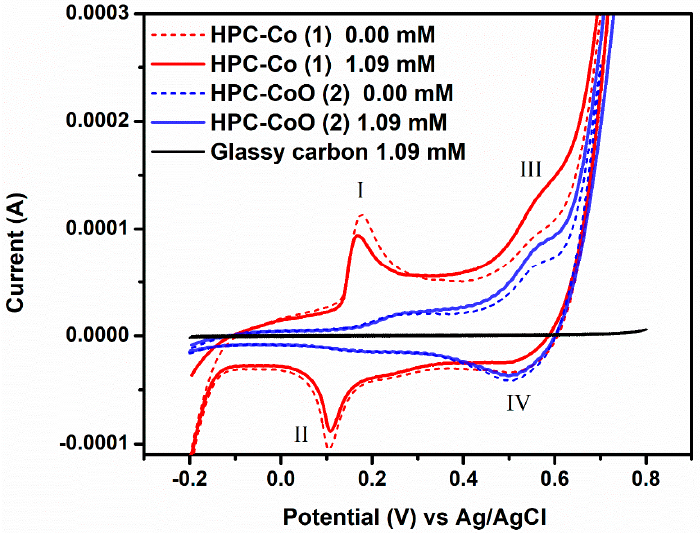
Figure 9. Cyclic voltammetry in 0.1 M NaOH solution at a scan rate of 25 mV s − 1 of the bare glassy carbon electrode in the presence of 1.09 mM fructose and of HPC-Co (1) and HPC-CoO (2) electrodes in the presence and absence of 1.09 mM fructose.